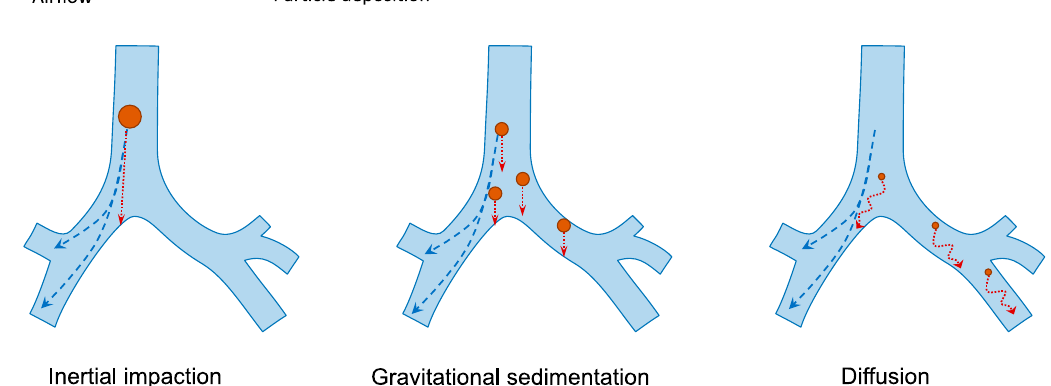
Figure 3. The three major mechanisms of particles deposition in the lungs. Inertia impaction occurs when large particles (>5 µm) cannot adjust to the change of airflow direction due to inertia and deposit on the airway walls, typically in the upper respiratory tract. Gravitational sedimentation is the settling of particles due to gravitational force. It mainly affects particles with size of 1–5 µm, which usually deposit in the small airways. Diffusion occurs when submicron-size particles having Brownian motion hit the surface of airway walls.